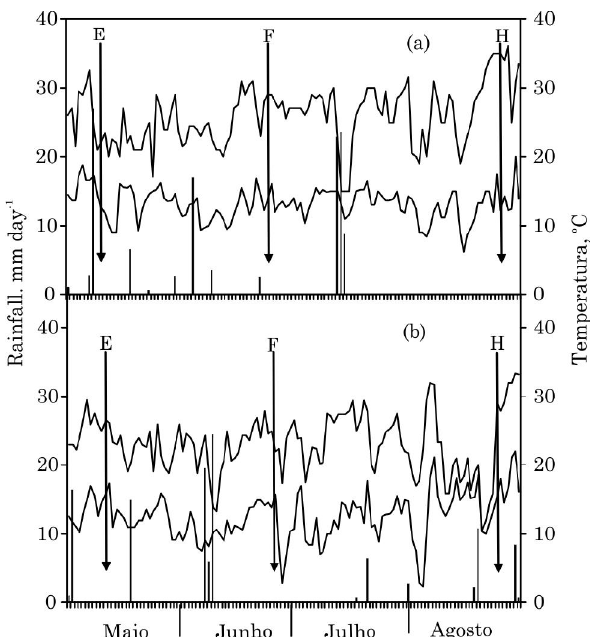
Figure 1. Rainfall (|), maximum ( ) and minimum temperature (–) in the experimental area during the months of May to August of 2010 (a) and 2011 (b), and dates of seedling emergence (E), flowering (F) and harvesting (H) of crambe. (Information provided by the Department of Rural Engineering,